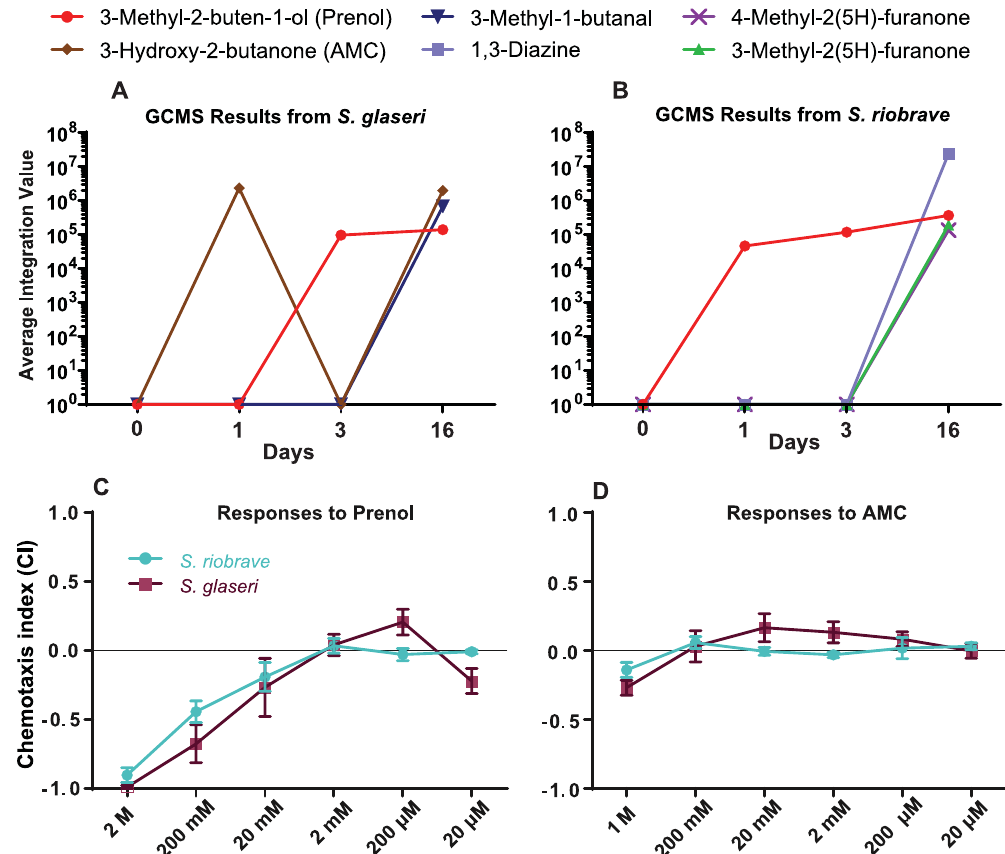
Figure 5. Panels A,B: Results from GC-MS of ( A ) S . glaseri and ( B ) S . riobrave infected G . mellonella hosts. Numbers represent integration values of peaks. This reflects the overall relative abundance of individual odors. Here we found that most odors are appeared in highest abundance at 16 days post infection (dpi), however two chemicals–AMC and prenol–stood out by appearing at earlier time points. 3-Hydroxy-2-butanone (AMC) is found in association with S . glaseri -infected hosts at 1 dpi and 16 dpi. 3-Methyl-2-buten-1-ol (prenol) is found in both S . riobrave and S . glaseri infected hosts, and appears at 1dpi (for S . riobrave -infected hosts only) as well as at 3 dpi, and 16 dpi in both S . riobrave and S . glaseri -infected hosts. Panels C,D: Results of dose response curves for ( C ) 3-Methyl-2-buten-1-ol (prenol) and ( D ) 3-Hydroxy-2-butanone (AMC). These show the responses of both S . glaseri and S . riobrave IJs to various concentrations of these chemicals. It is worth noting that the concentrations listed are what was applied to the experimental arena, but are certainly higher than the concentration experienced by the nematodes. Error Bars represent